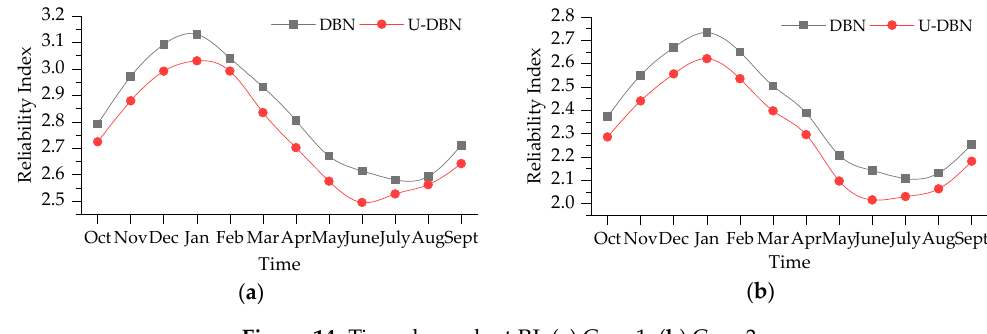
Figure 14. Time-dependent RI: ( a ) Case 1; ( b ) Case 3.